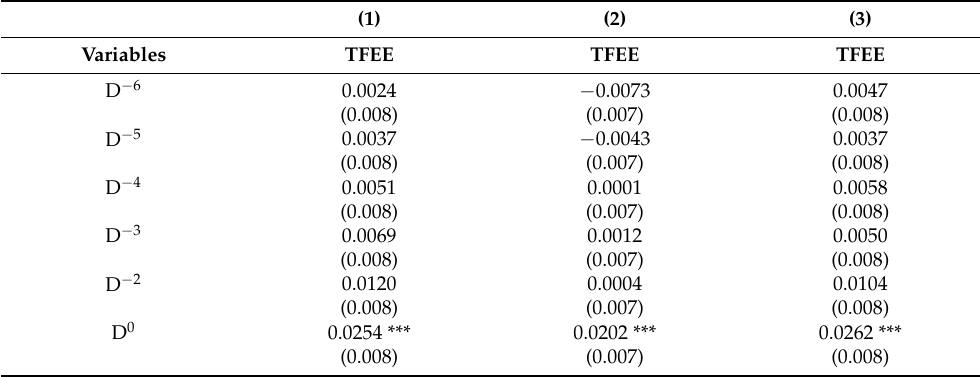
Table 3. Parallel trend